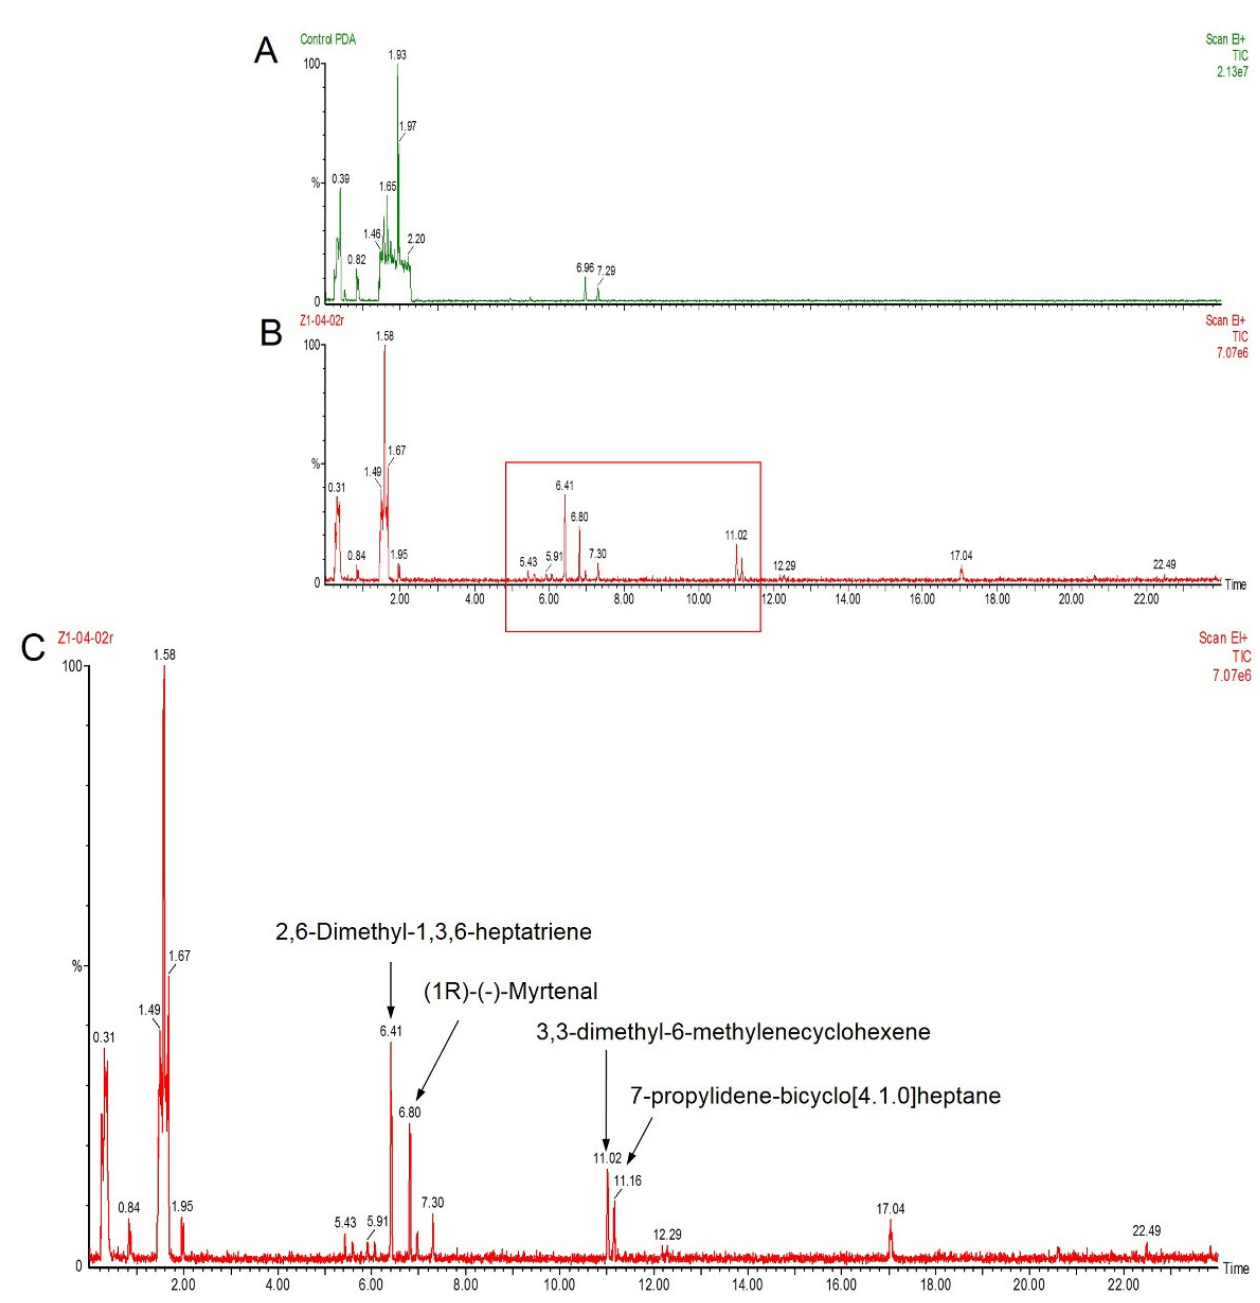
Figure 4. GC/MS profiling of volatiles emitted by Z1-04-02: mass spectrum of PDA alone ( A ), mass spectrum of Z1-04-02 ( B ), and qualitative volatile compounds of Z1-04-02 ( C ).